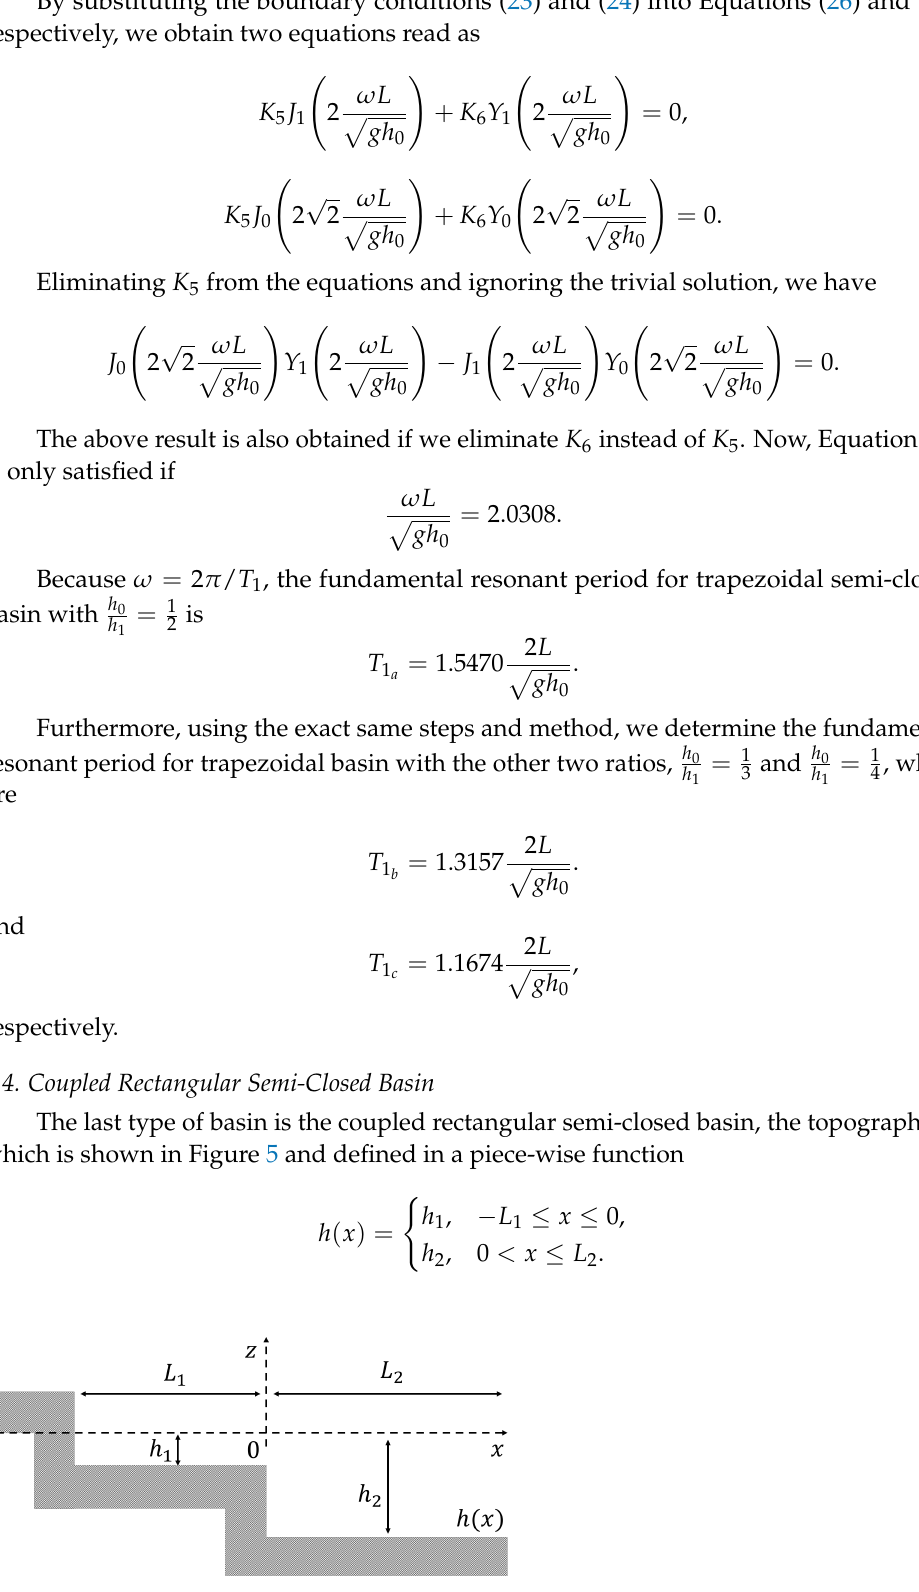
Figure 5. Coupled rectangular semi-closed